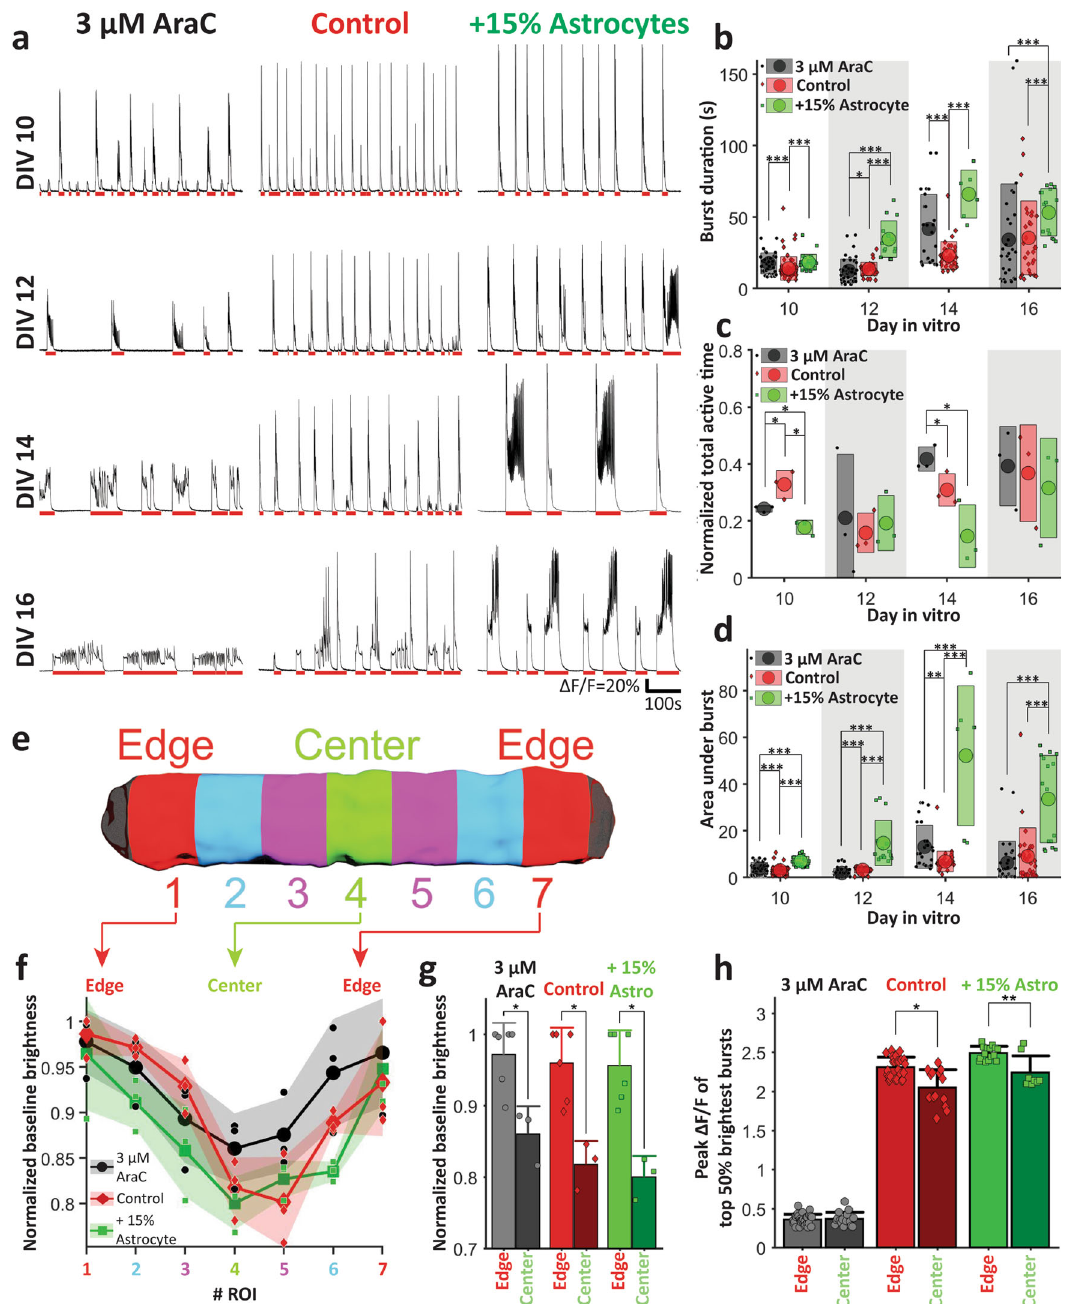
Fig. 4 Activity analysis in linear 3D cultures. a Ca 2 + activity in culture with chronically applied AraC (left), control culture (middle), and culture with + 15% rat astrocytes (right) on (from top to bottom) DIV 10, 12, 14, and 16. Mean (circle) with standard deviation (rectangle) of b individual burst durations, c normalized total active time, and d area under curve of individual bursts on different DIVs. e Schematic of a culture with seven segments that were analyzed separately. f Normalized baseline brightness for each segments of different types of cultures on DIV 16. (Individual points indicate normalized baseline value for a speci fi c type of culture on a speci fi c DIV, large dotted solid lines indicate mean, shaded regions indicate standard deviation). g Mean with standard deviation of normalized baseline brightness of edge (segments 1 and 7) and center (segment 5) for different types of cultures on DIV 16. h Mean with standard deviation of peak brightness change ( Δ F / F ) during bursts at edge (segments 1 and 7) and center (segment 5) for different types of cultures on DIV 16. For b and d , for 3 μ M AraC, Control and + 15% astrocytes cultures, n = 37, 63, 26 on DIV 10, n = 46, 31, 15 on DIV 12, n = 27, 36, 6 on DIV 14, and n = 31, 28,16 on DIV 16, respectively. n is the number of bursts counted; three cultures were analyzed for each case. For c , n = 3 cultures for each case, for g , n = 6 for edges and n = 3 for centers, n being number of segments analyzed. Three cultures were analyzed (two edge and one center segment from each culture). For h , for 3 μ M AraC n = 64, 31, for control n = 52, 28 and for + 15% astrocytes n = 30, 16 for edge and center, respectively, n is the number of bursts. Six edge segments and three center segments were analyzed from three cultures (two edge segment and one center segment each). For b – d , g , h asterisks indicate results of two-sample Kolmogorov – Smirnov test (* p < 0.05, ** p < 0.01, and *** p <